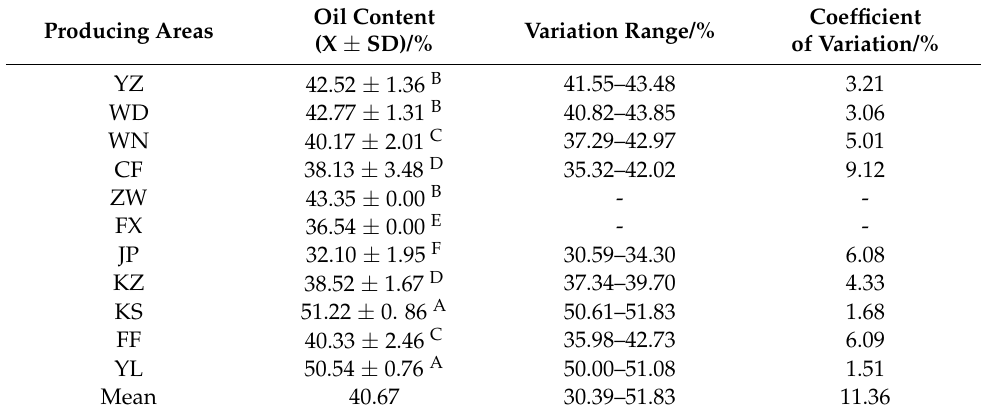
Table 1. Oil content of A. truncatum kernel from different producing areas. Producing